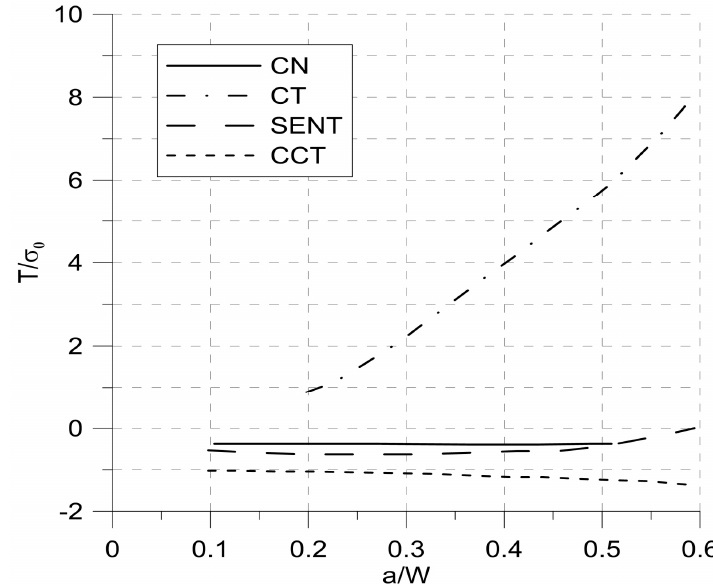
Figure 1. Dependence of T-stress on the geometry of the samples, where a—crack length, W—sample width, CN—corner notched specimen, CT—compact tension specimen, SENT—side edge notched tension specimen, CCT—center cracked tension specimen.